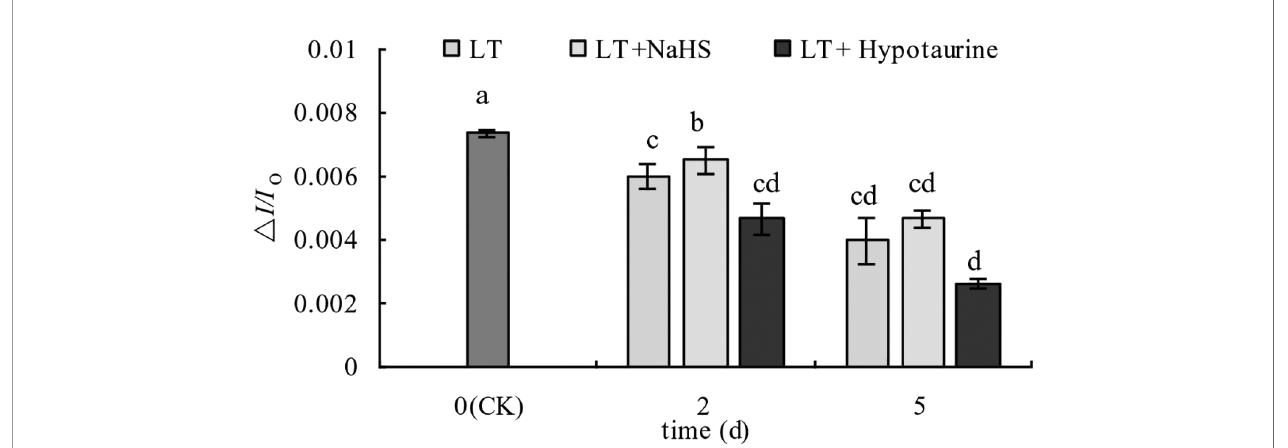
FIGURE 7 | Effects of exogenous NaHS and Hypotaurine on △ I/I o of blueberry leaves under low temperature stress. The data in the fi gure are from fi ve replicated experiments (n = 5), and represent means ± standard error (SE). Different small letters show signi fi cant differences ( P < 0.05). CK: room temperature control at 25°C; LT: low temperature treatment; LT + NaHS: low temperature treatment at 4 – 6°C after spraying 0.5 mmol·L – 1 NaHS; LT + Hypotaurine: low temperature treatment at 4 – 6°C after spraying leaves with 200 m mol·L – 1 hypotaurine.